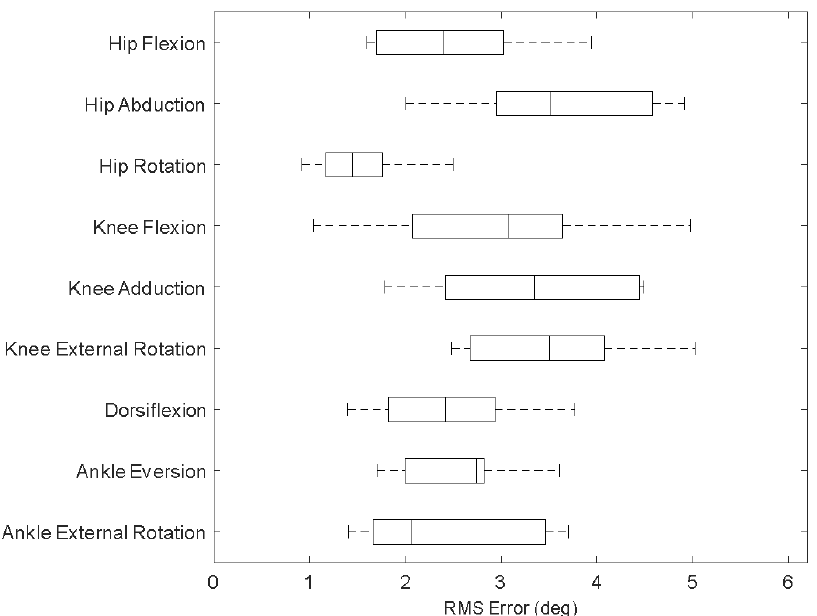
Figure 5. Root mean square (RMS) errors between the 3D angles obtained by IMUs readout and those obtained using camera recordings (as the reference system). First, the RMS error was attained between IMU-based and motion capture-based angles for each trial. Then, these values were averaged over all trials of each participant. Then, the RMS of all the participants’ obtained average values is presented as boxplots.